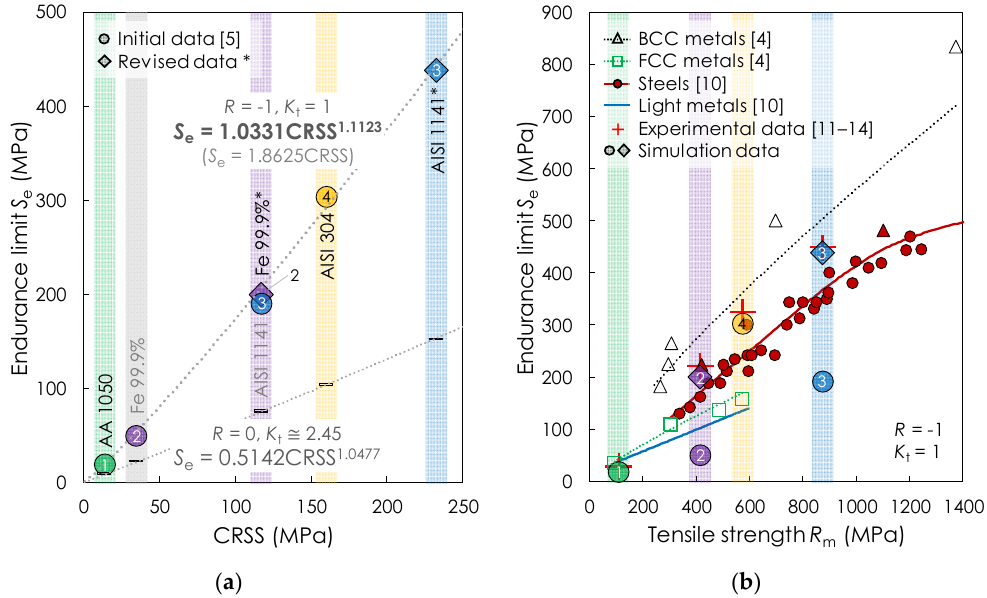
Figure 1. ( a ) Relation between endurance limit ( S e ) values (from [5] and updated with the new results for the Fe 99.9% and for the steel AISI 1141, marked with diamonds and with *) of the investigated metals and their critical resolved shear stress (CRSS) values [6–9]. ( b ) Relation between S e and ultimate tensile strength ( R m ) values for various metals [4,10–14], including new simulation-based S e values (diamonds) and those from [5] (circles). Simulation-based S e values for the standard loading case characterized by loading ratio R = −1 and stress concentration factor K t = 1 are obtained from the values characteristic for R = 0 and K t ≅ 2.45 by using an approach taking into account mean stress and/or loading ratio [10] in combination with the notch sensitivity approach [15] (see Appendix A for more details).